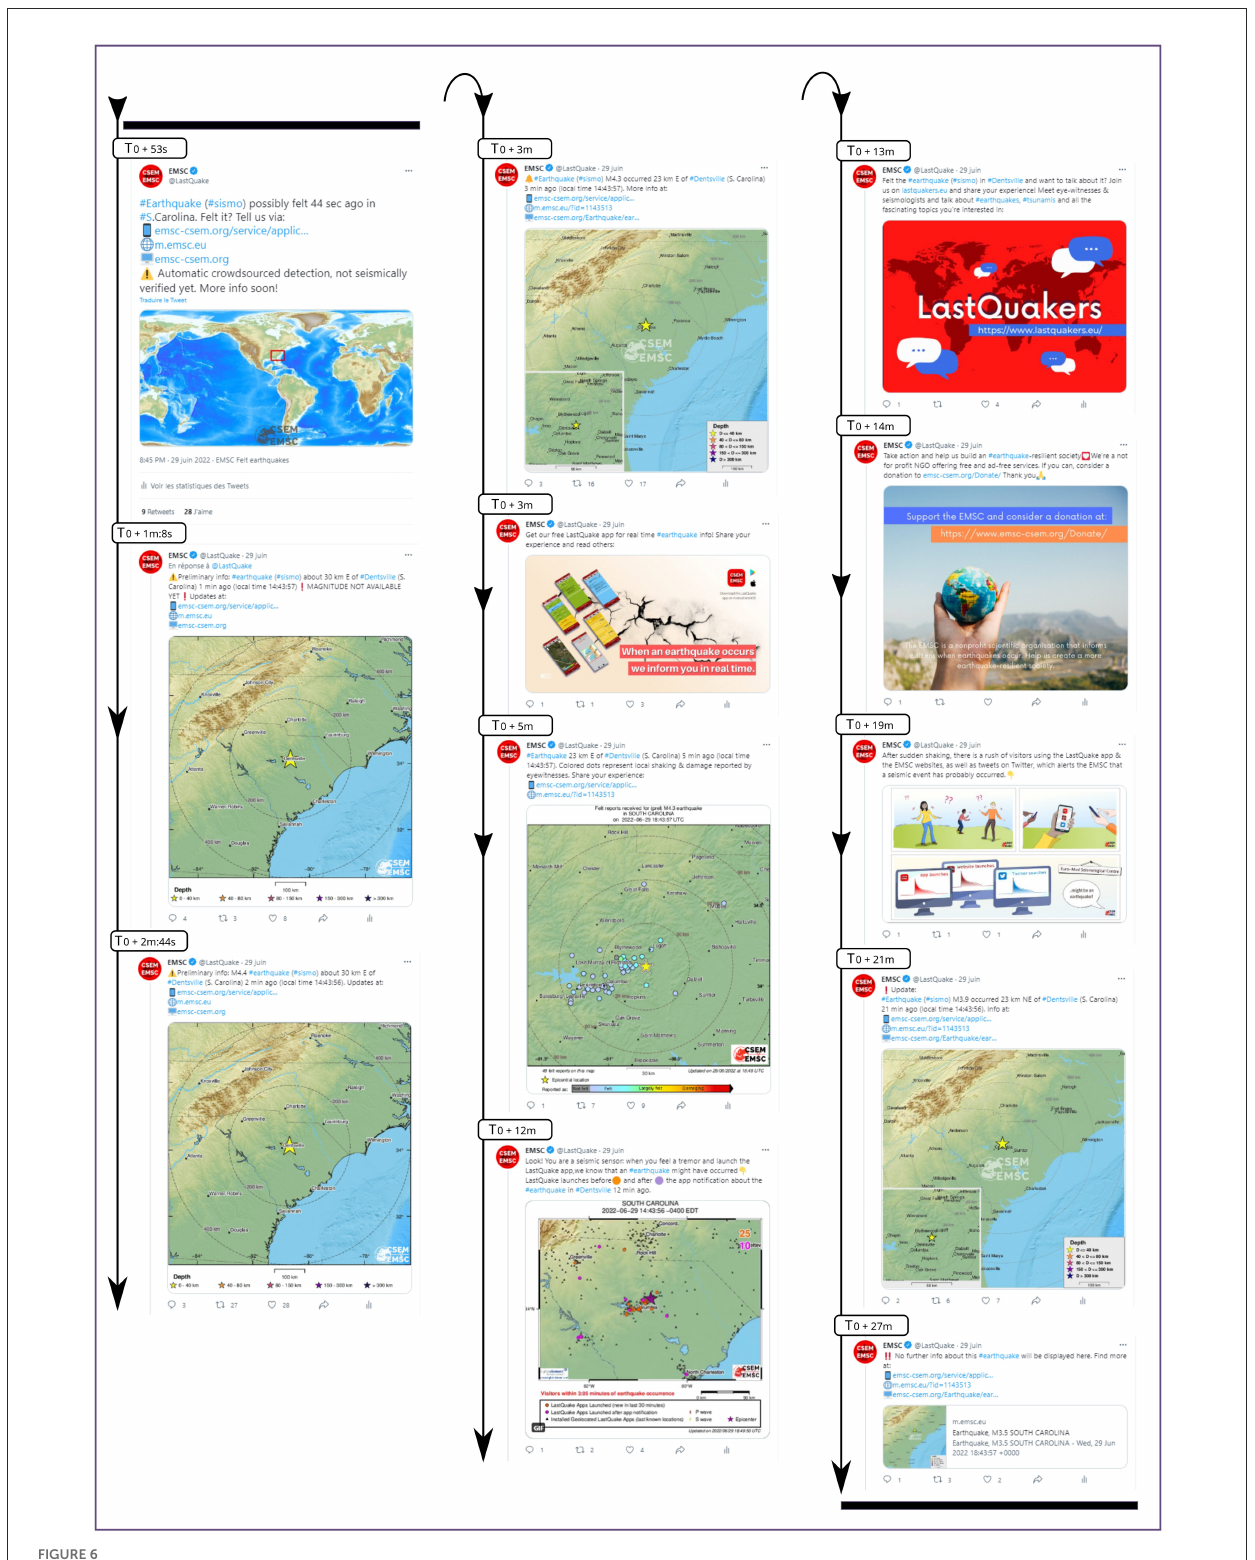
FIGURE6 Threads of tweets automatically published in relation to South Carolina’s M3.5 earthquake of 29 June 2022 and their publication times after earthquake occurrence. This earthquake was in the category “small with audience” (Figure 4). This category is considered to open a teachable moment and include in this case information on the system (tweet numbers 7 and 10). The second tweet presenting an epicentral location without magnitude estimate originated from the CsLoc method based on the combined analysis of crowdsourced and seismic data for the rapid location of felt earthquakes (Steed et al., 2019; Bondár et al.,